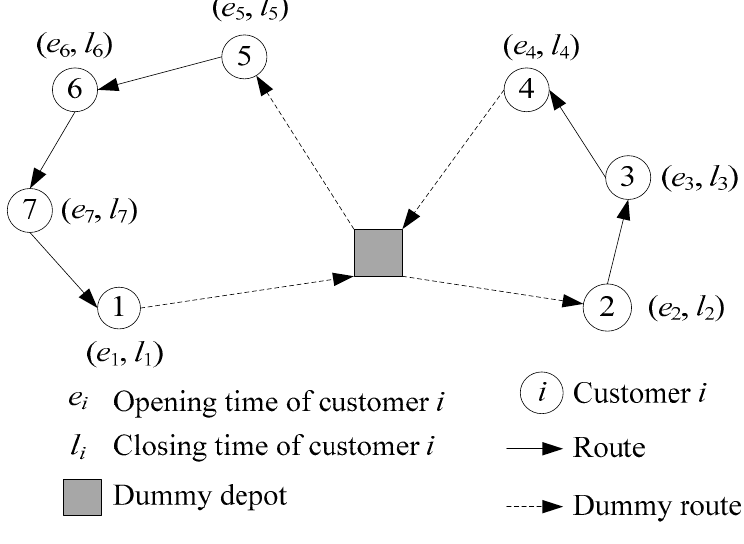
Figure 1. Illustration of PCPTW.